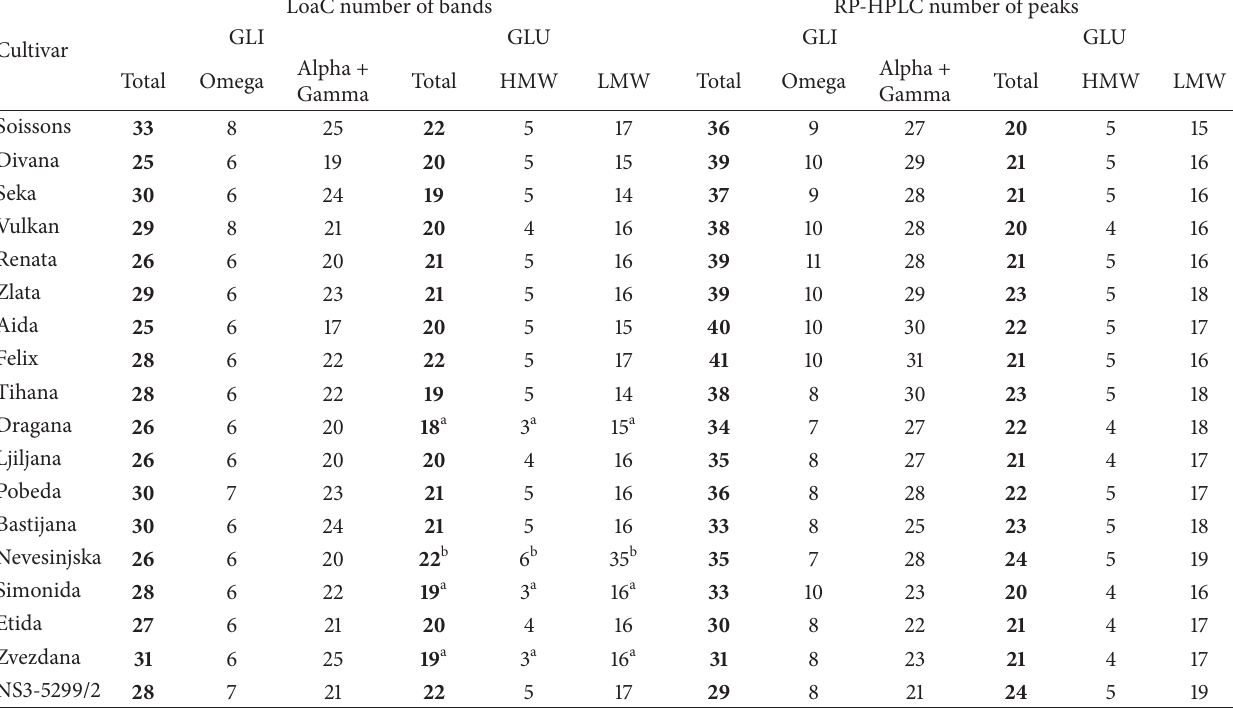
Table 4: Comparison between number of bands as determined by LoaC and number of peaks as determined by RP-HPLC.